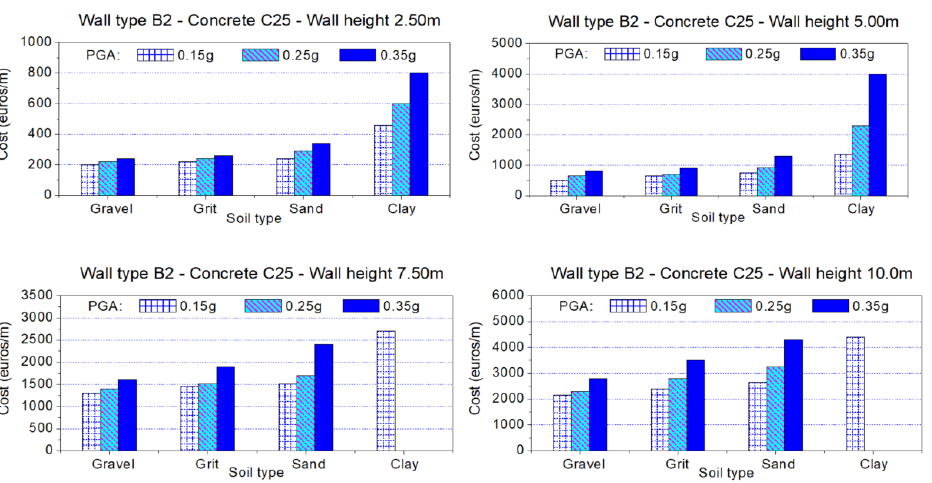
Figure 9. Cost of retaining walls type B1 made by reinforced concrete C30.